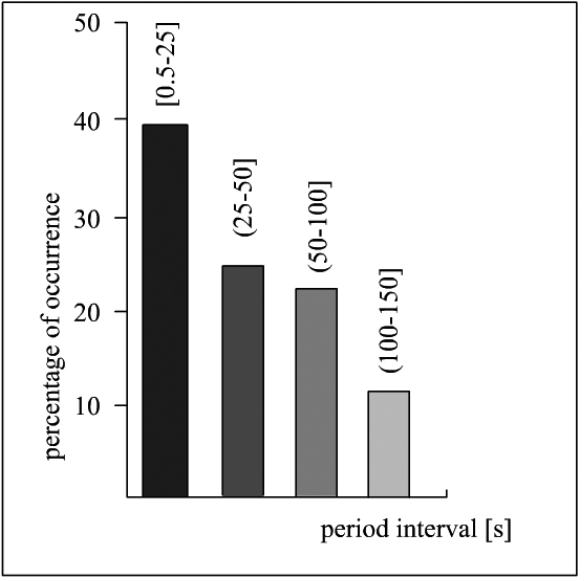
Figure 9. Percentage of occurrence of the periodicities at the vari- ous time